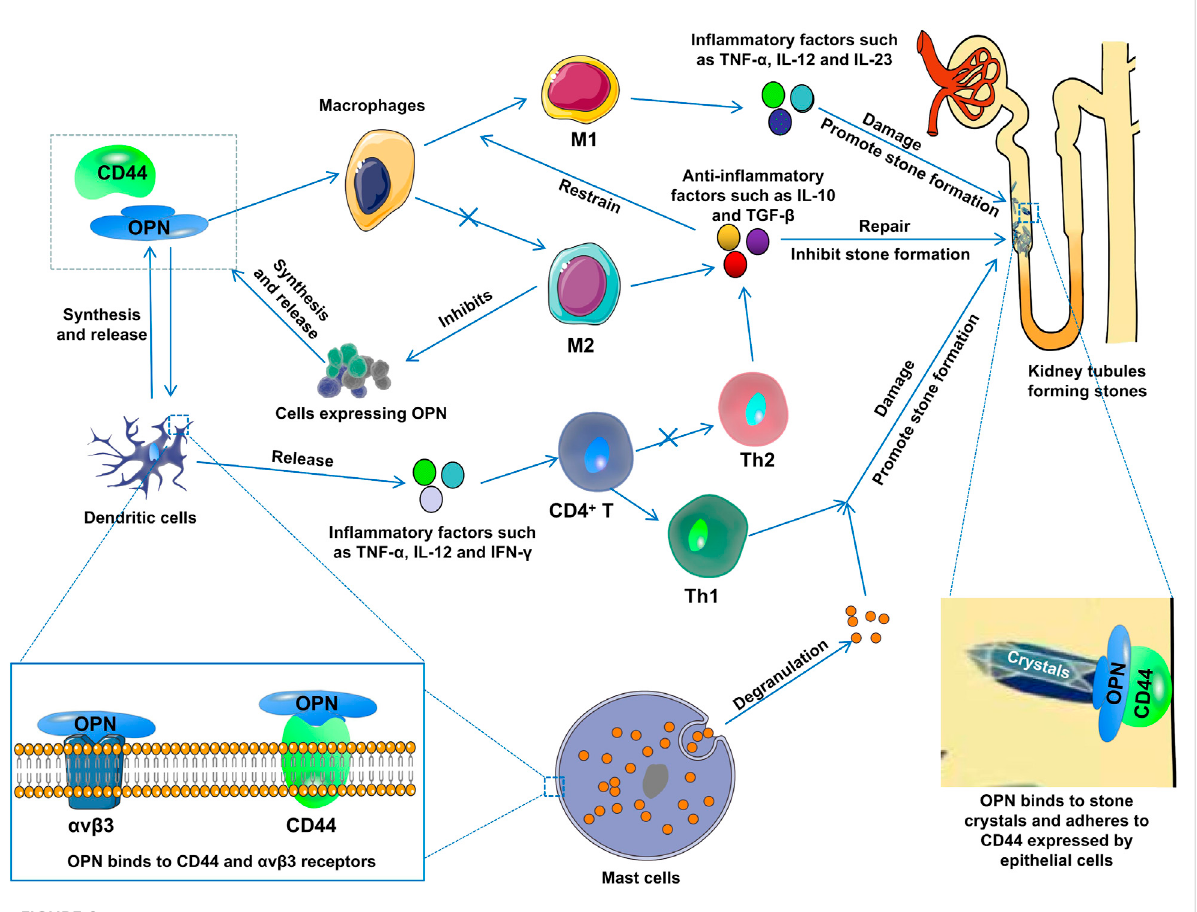
FIGURE 2 OPN induces macrophages to differentiate into M1 macrophages, induces T cells to differentiate into T1 cells, and activates mast cell degranulation to release various in fl ammatory mediators, which damage kidneys and promote stone